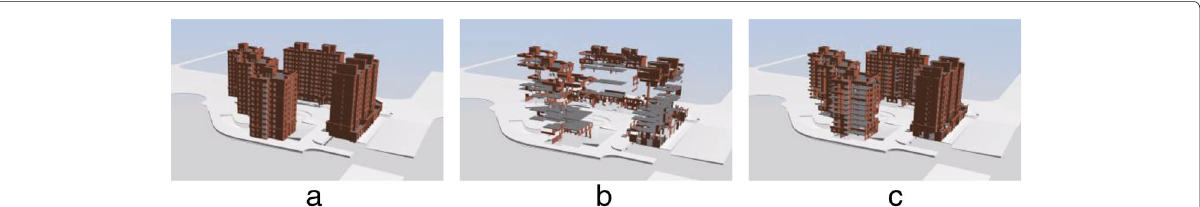
Fig. 9 Comparison between the conventional dynamically loading method and proposed model for the same industry foundation classes file where 35% data of the same model is loaded for the two methods. a The whole model b Conventional method with 35% data loaded c Our method with 35% data loaded